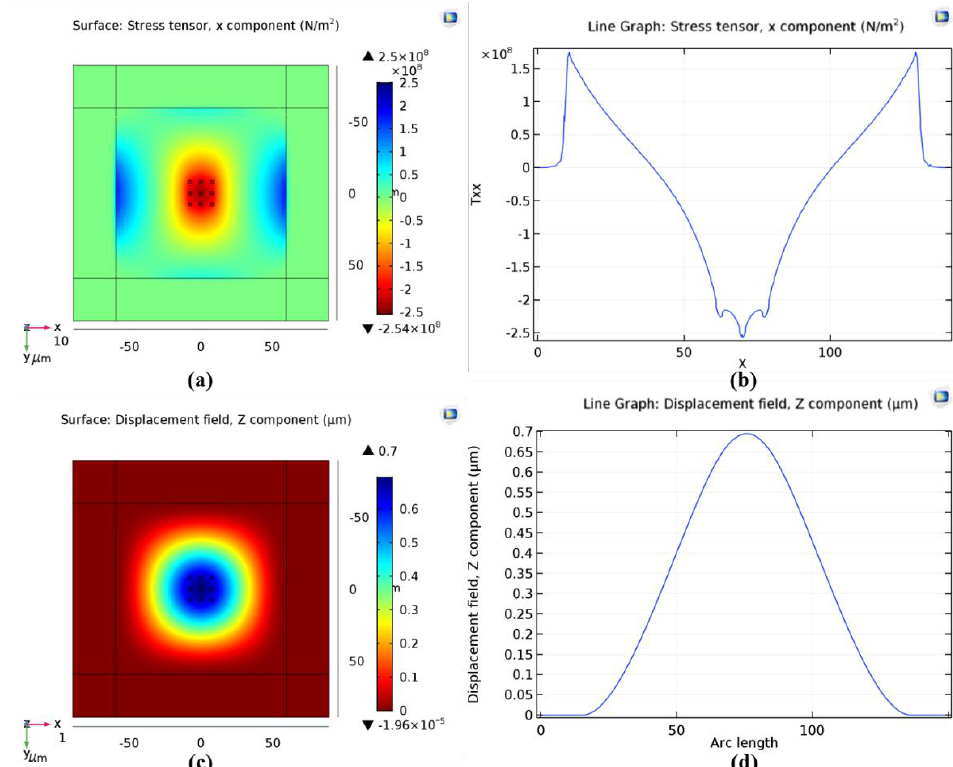
Figure 4. COMSOL simulation results of the stress and displacement of silicon nitride diaphragm caused by stiction effect. ( a , b ) Maximum stress occurs at the edge of the silicon nitride diaphragm, and its value is approximately 167.71 MPa; ( c , d ) Maximum displacement occurs at the center of the silicon nitride diaphragm, and its value is approximately 0.69 μm.